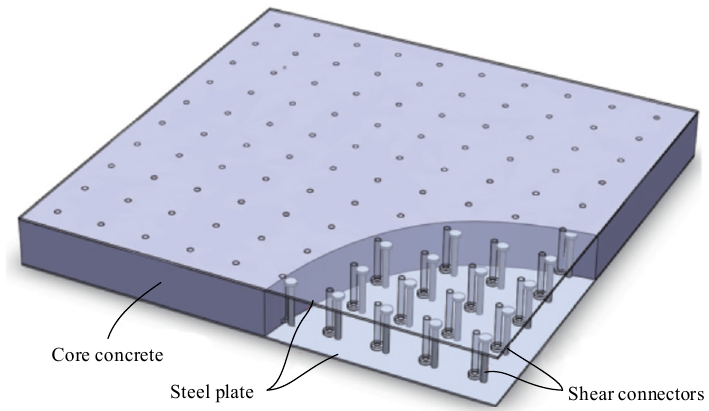
Figure 1. Double steel plate – concrete combination structure.